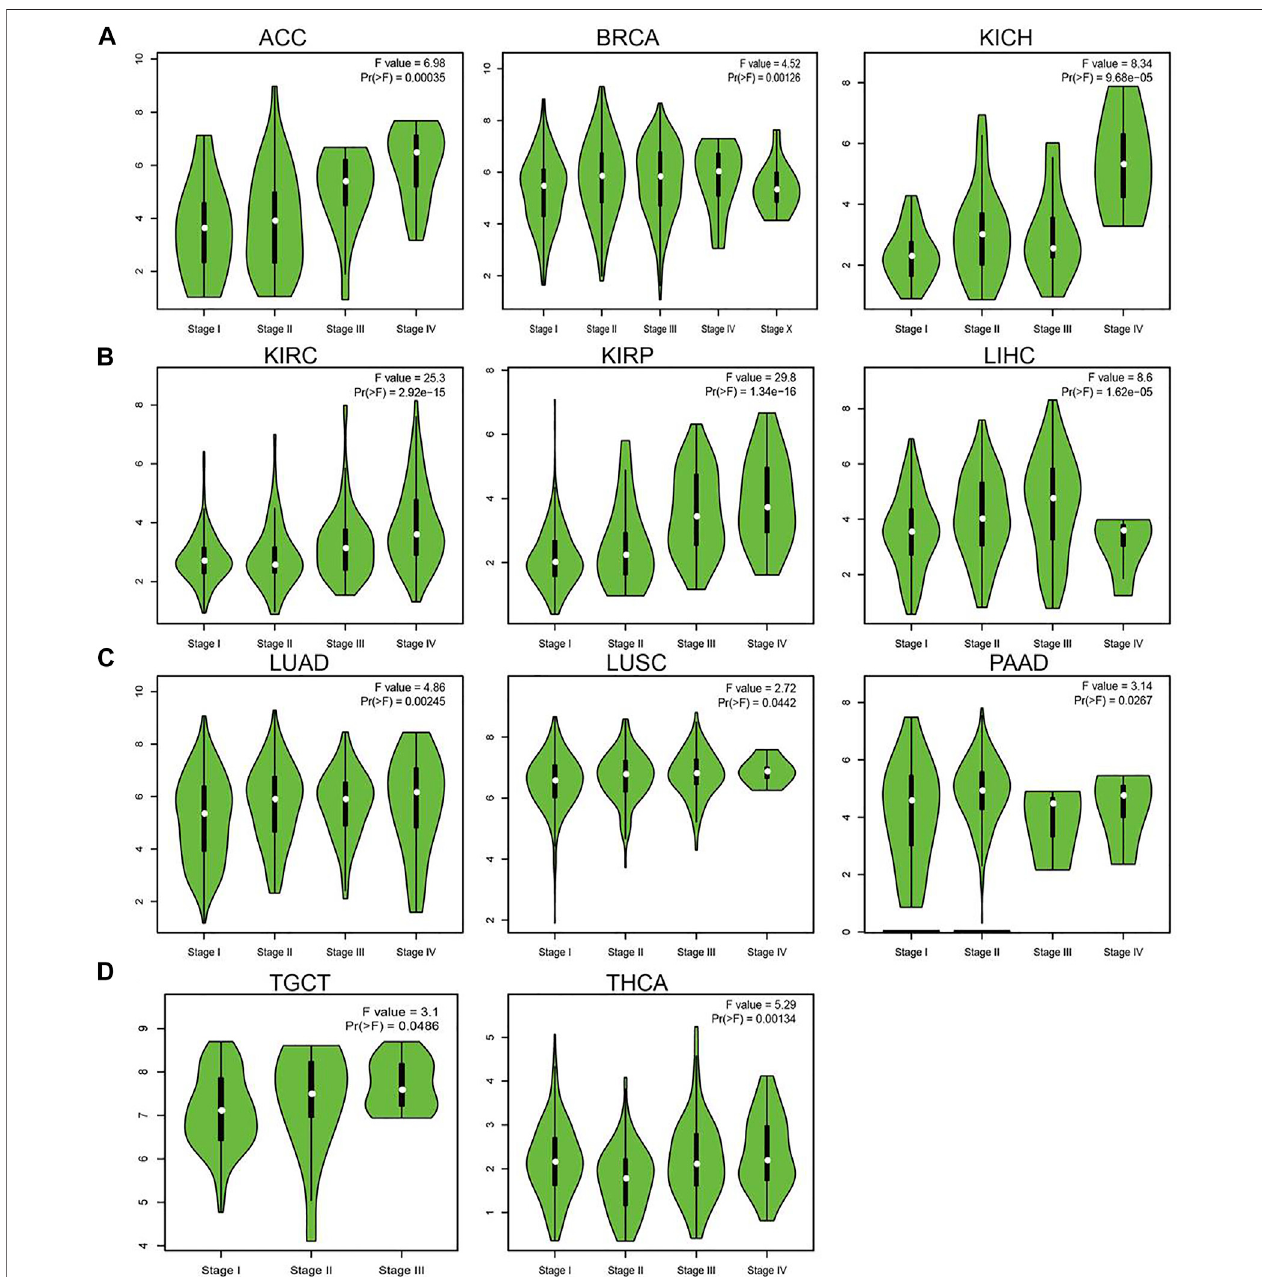
FIGURE 2 | Analysis of the tumor stage for UBE2C in human cancers. (A) The tumor stage for UBE2C in ACC, BRCA, and KICH; (B) KIRC, KIRP and LIHC; (C) LUAD, LUSC, and PAAD; (D) and TGCA and THCA analysis by the GEPIA database.